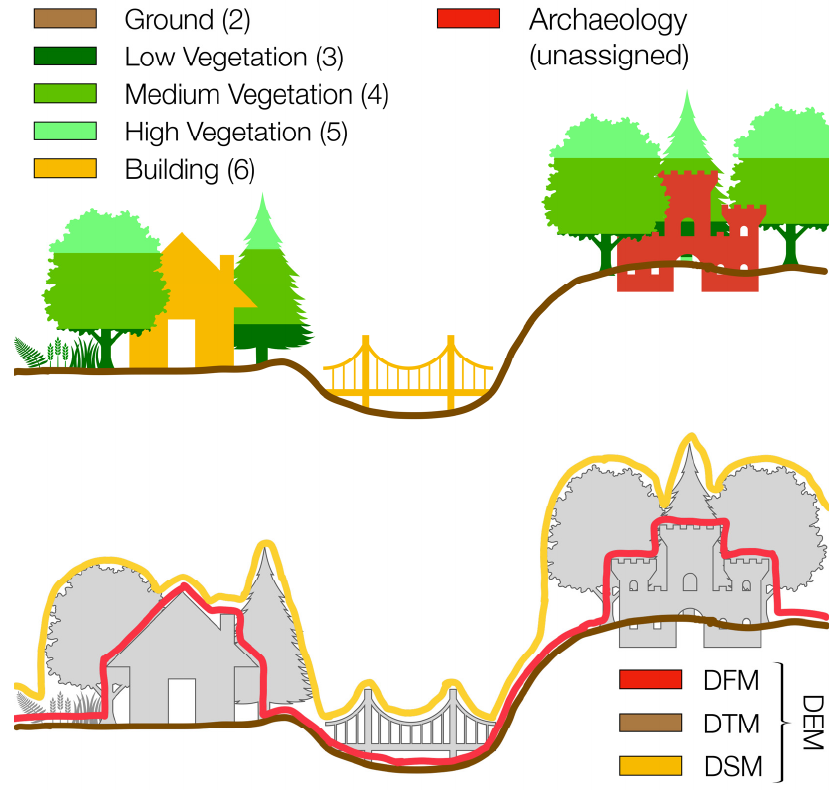
Figure 1. An outline of the differences between DEMs, DFMs, DTMs, and